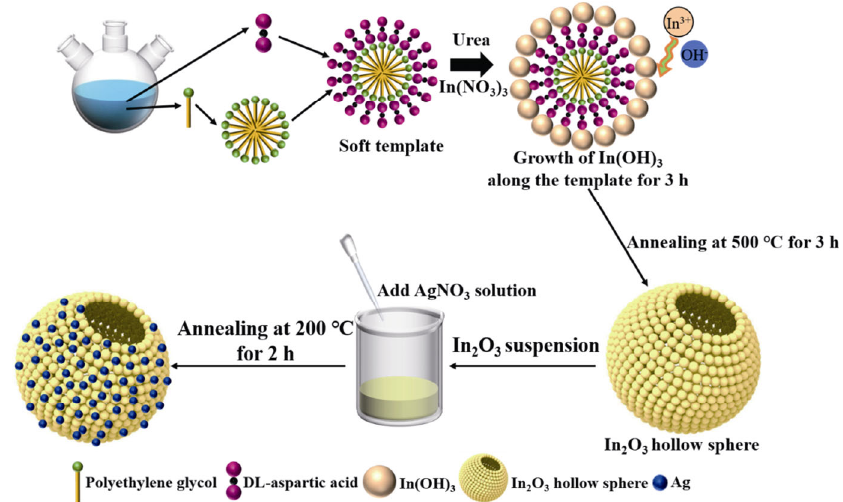
Fig. 1 Synthesis steps of Ag nanoparticle-decorated In 2 O 3 hollow